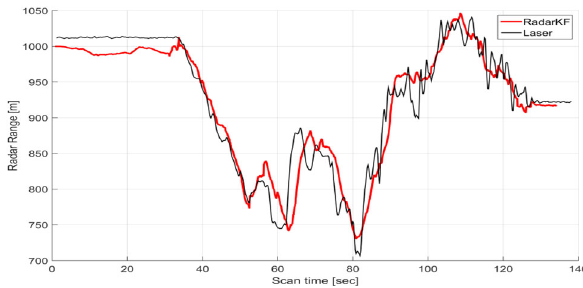
Fig. 14 Radar creep measurement compared with laser scanner data in close agreement